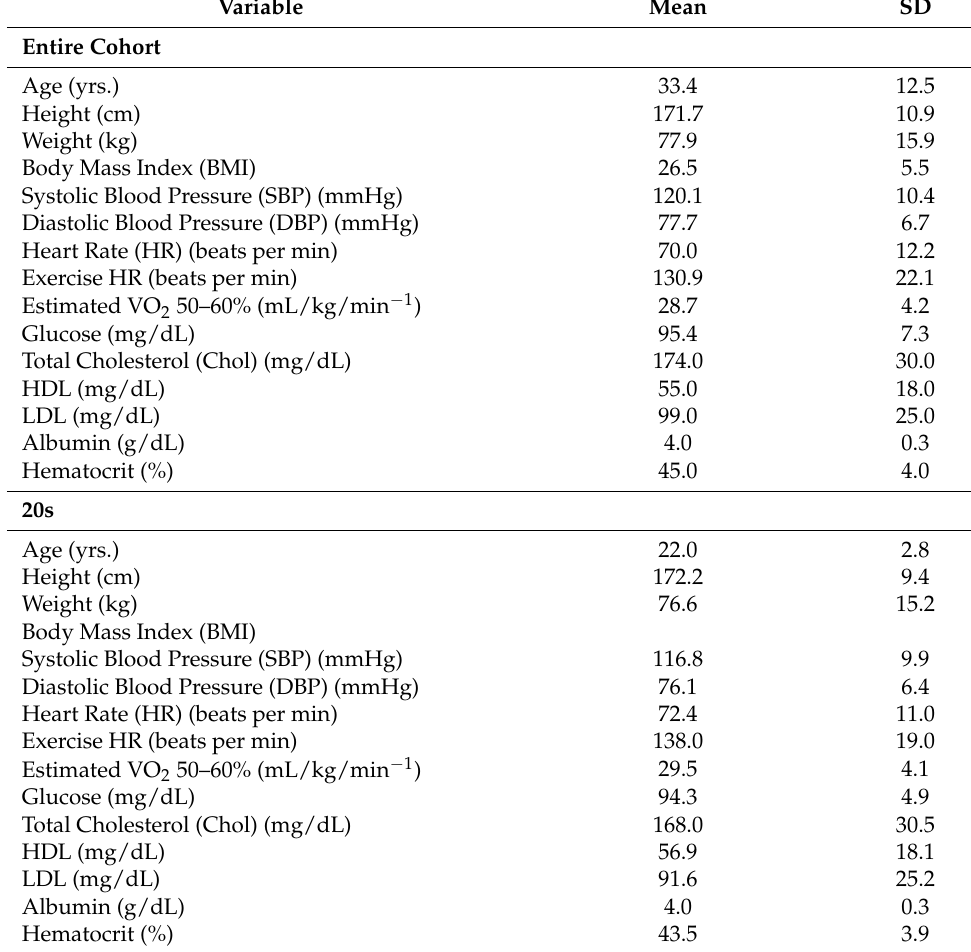
Table 1. Participant